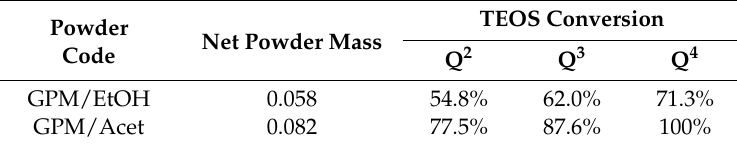
Table 2. Hypothetical TEOS conversions based on the mass of dried powder.